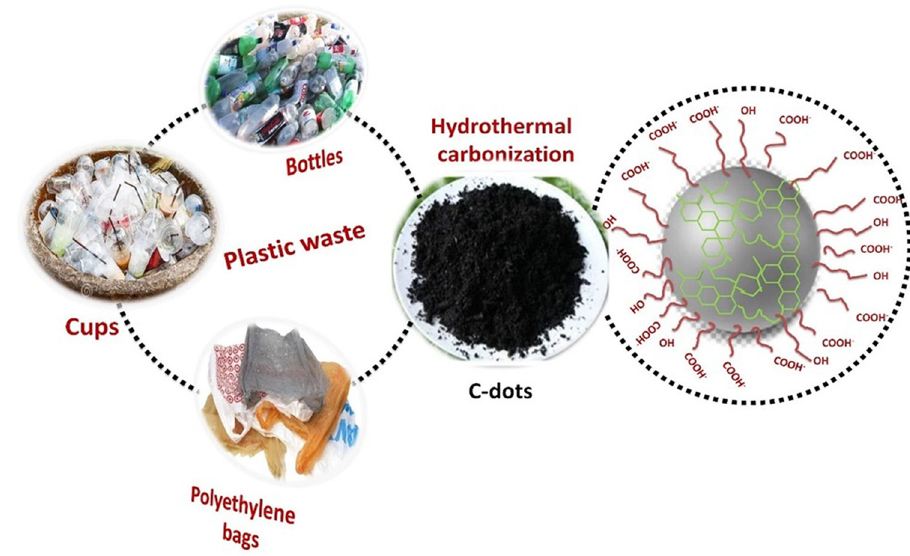
Figure 13: Schematic displaying the production of FL - CQDs from various types of plastic waste. Copied with permission from ref. [ 145 ] ; Elsevier,